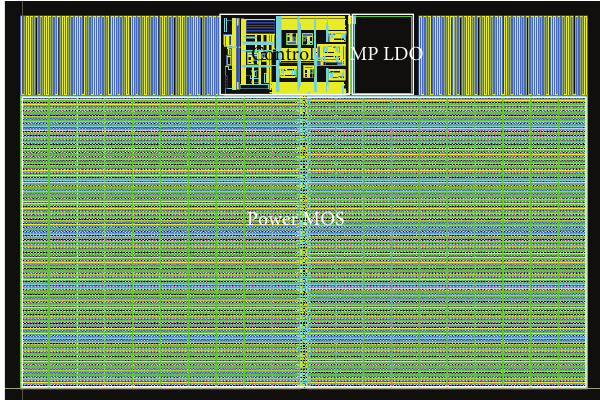
Figure 13: Layout of proposed